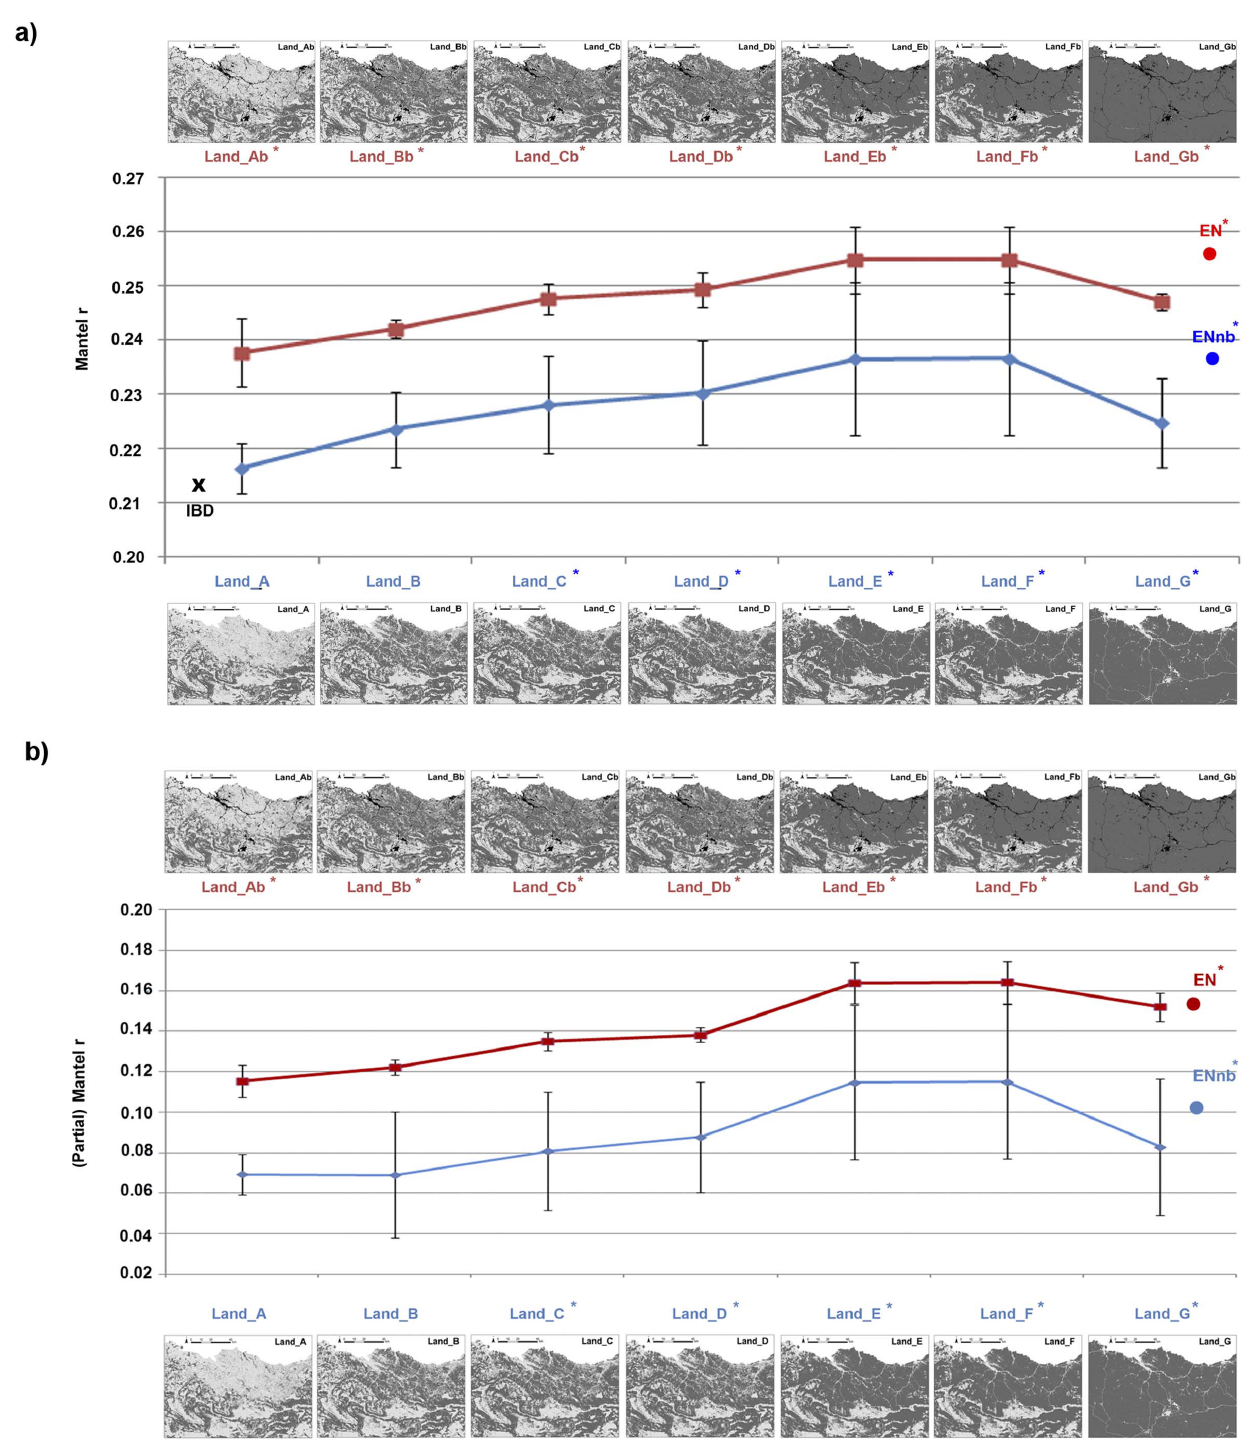
Figure 4. Mantel r results for the different landscape resistance maps evaluated (log transformed). a ) Pearson correlation coefficients (Mantel r) between genetic distance and effective distance (log transformed) and b ) Pearson correlation coefficients (Partial Mantel r) between genetic distance and effective distance (log transformed) after factoring out the effect of the Euclidean distance in the different landscape resistance maps examined. Models marked with an asterisk correspond to the models supported within the causal modeling framework [30]. doi:10.1371/journal.pone.0110552.g004 by the hypothesis cube (Fig. 3), the different resistance values transformed (Table 2; Fig. S1 and Fig. S2) and the untransformed evaluated (5, 25, 50, 100) slightly modified the (partial) Mantel distances (Table S3; Fig. S3 and Fig. S4), but overall a consistent correlation results obtained for each model for both the log pattern was obtained.